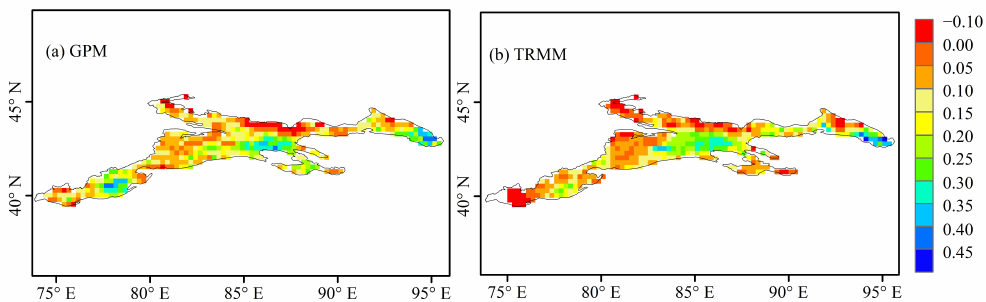
Figure 4. Correlation between GPM, TRMM and CGDPA from 1 April 2014 to 31 March